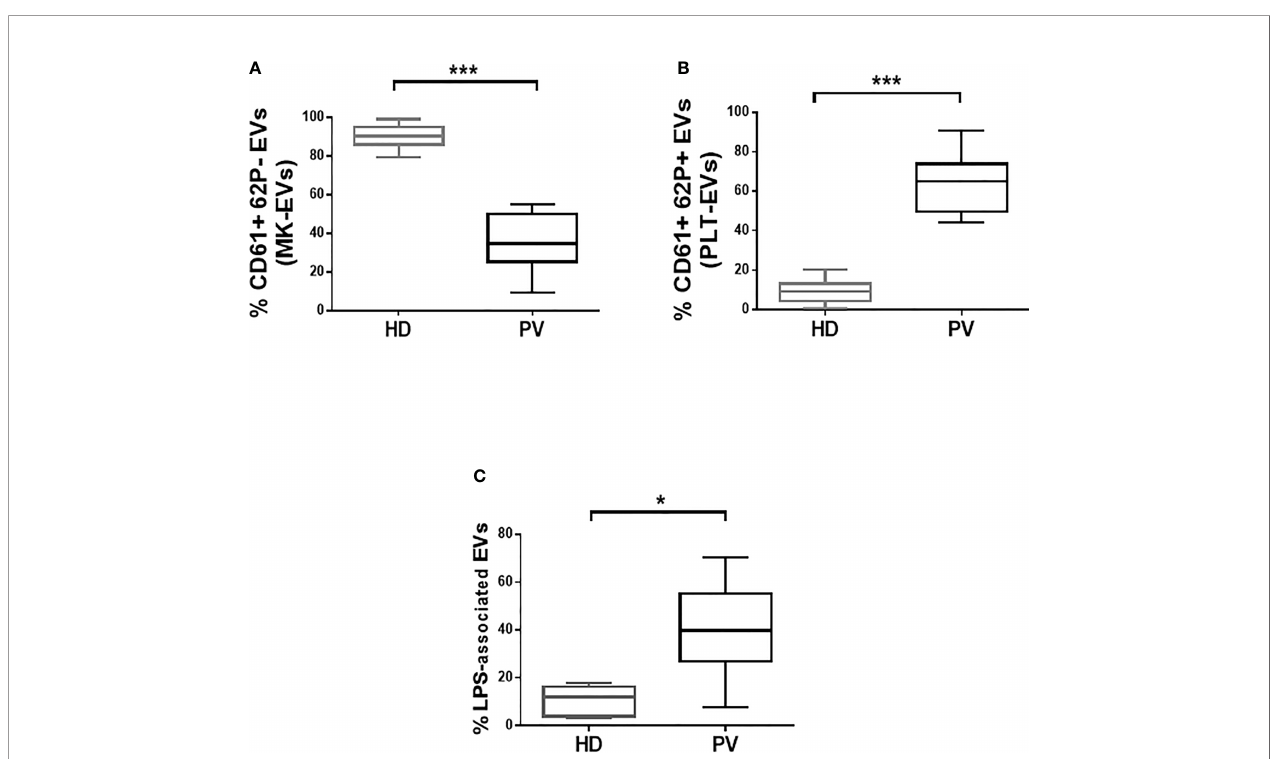
FIGURE 1 | Proportion of plasma MK- and PLT-EVs, and of isolated LPS-associated EVs in patients with PV and HD. (A, B) MK-EVs and PLT-EVs pro fi le of PV patients (n = 38) and HD (n = 30). Data are expressed as percentage of MK-EVs and PLT-EVs and presented as min to max with median (Mann-Whitney test; *p < 0.05; ***p < 0.001). (C) Proportion of isolated LPS-associated EVs of PV patients (n = 28) and HD (n = 20). Data are expressed as percentage and presented as min to max with median (Mann-Whitney test; *p <